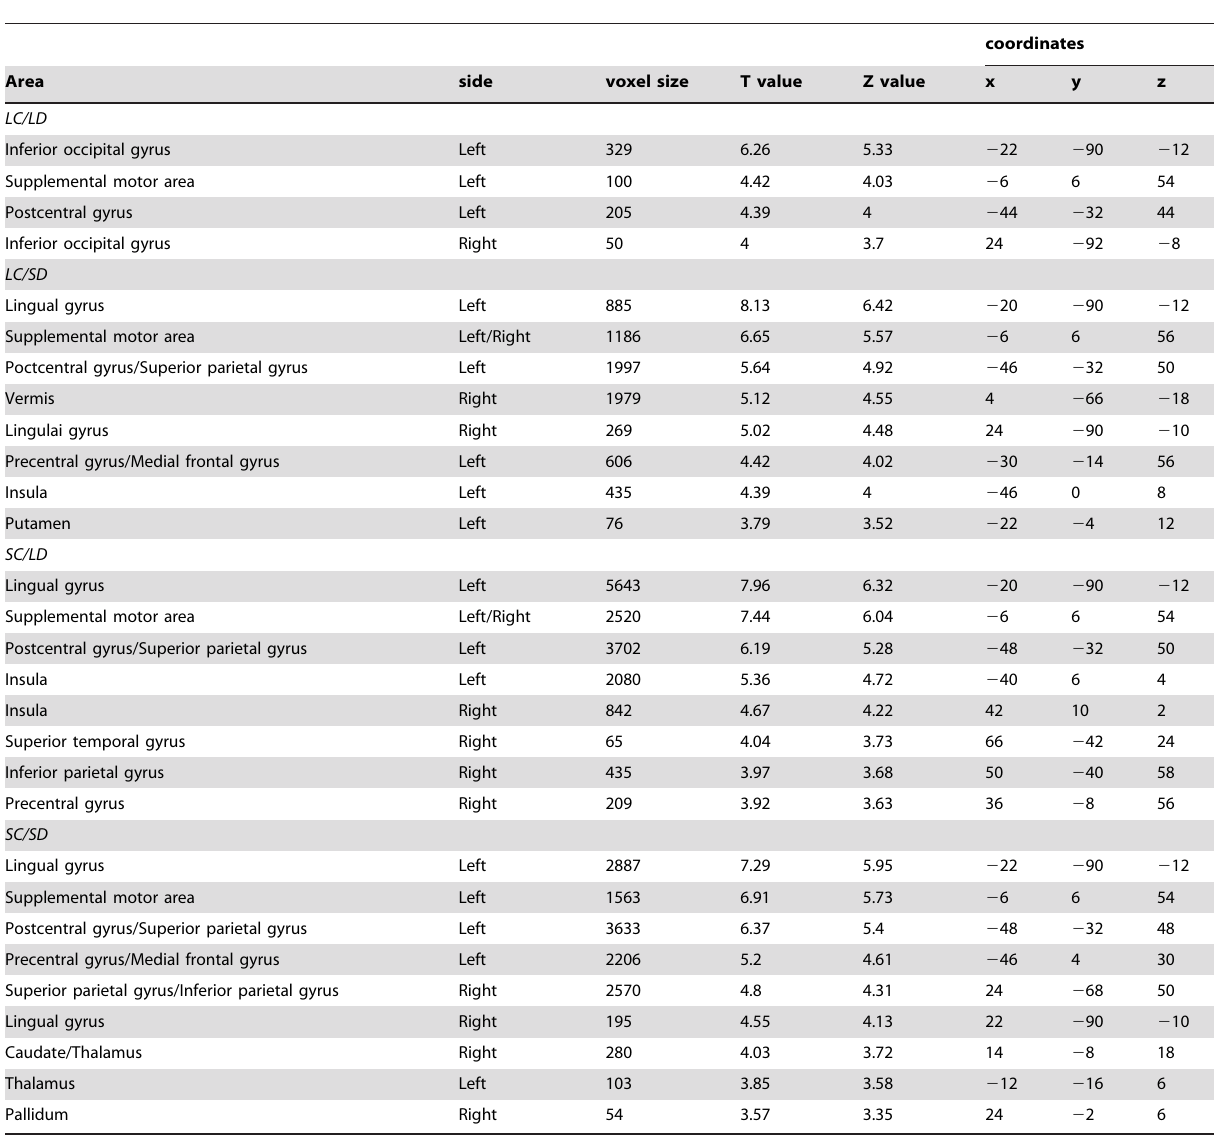
Table 2. MNI coordinates and statistical details for areas that were activated in each